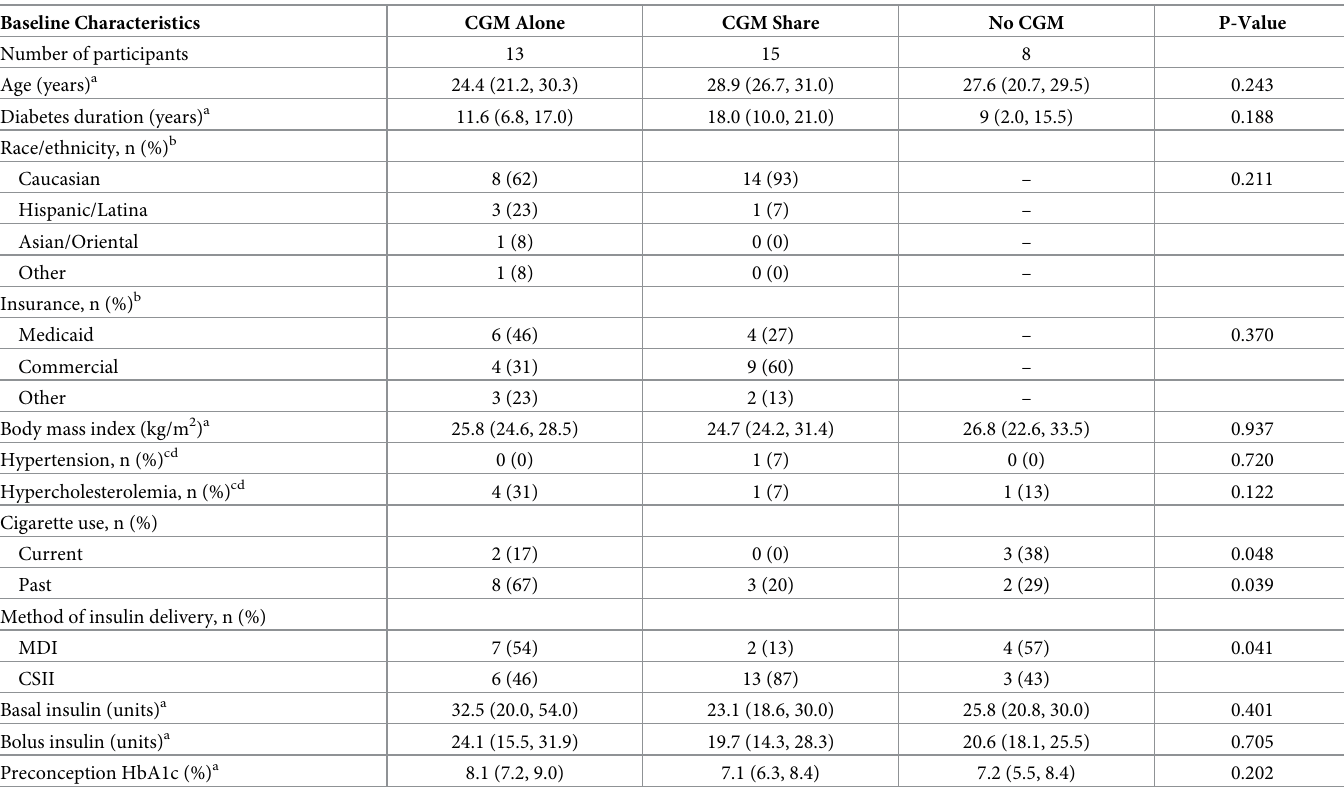
Table 1. Baseline